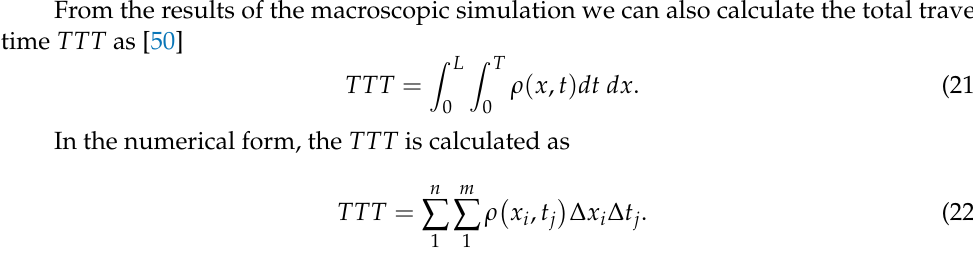
Table 2. Macroscopic simulation results.